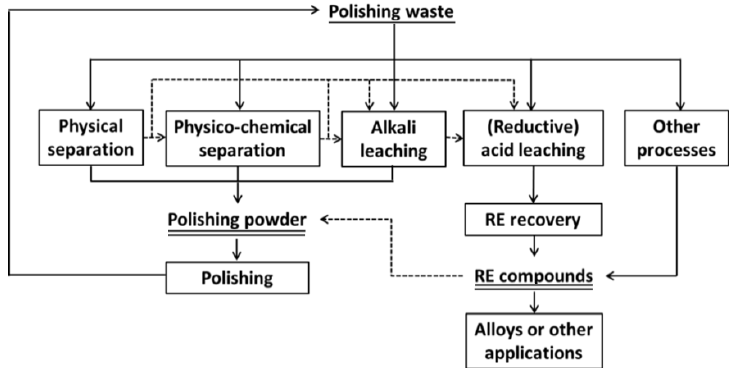
Figure 5. Different processes used for recovery of rare earths from glass polishing waste for reusing and recycling applications.